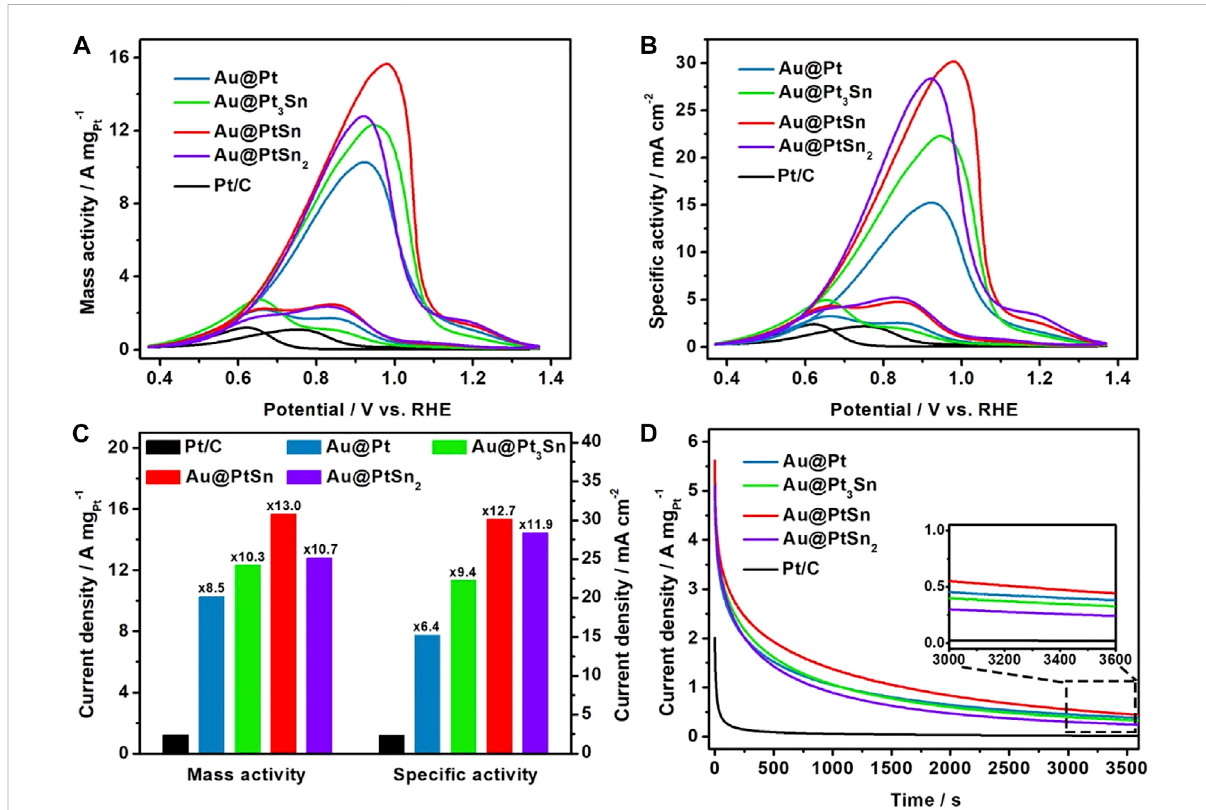
FIGURE 4 (A,B) Cyclic voltammograms (CV) curves normalized by Pt loadings and ECSAs, respectively (C) mass and speci fi c activities at the peak position of forward curves and (D) current-time (I-t) curves at 0.72 V of the Au@Pt x Sn y core-shell NPs and commercial Pt/C in Ar-saturated 1 M KOH +1 M ethanol solution at a scan rate of 50